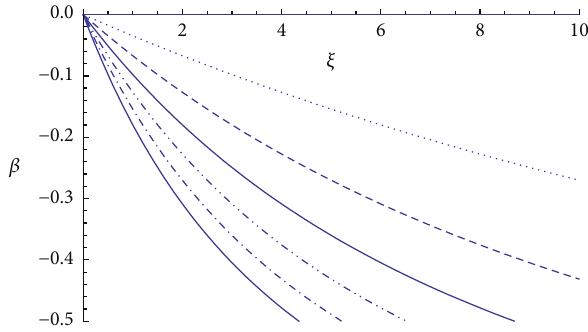
Figure 2: The asymmetry parameter 𝛽 = Λ 𝑡 /Λ 𝑟 as a function of 𝜉 for values of 𝑎 = 0, 0.25, 0.50, 0.75, 1.0, 1.25, 1.50 increasing